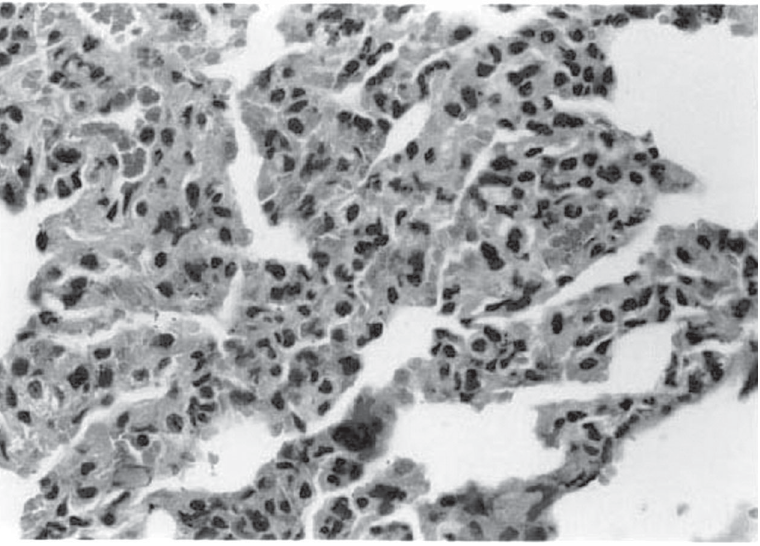
Figure 3. Histopathology of the lung of rat 8 (group II, reperfusion). The alveolar septa are thickened with edema and hypercellularity, mainly due to the neutrophil influx. The alveolar spaces are preserved (HE,